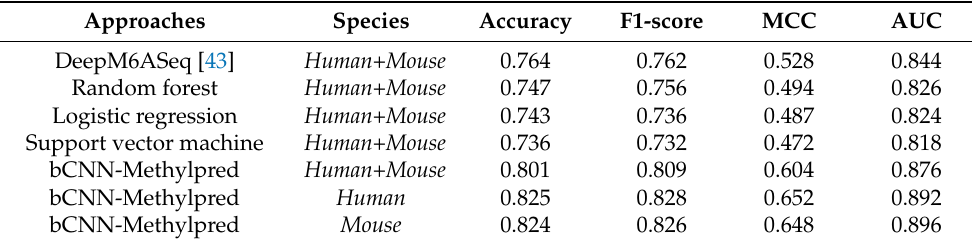
Table 11. Comparison of m6A site prediction using proposed and the state-of-the-art approaches based on human and mouse